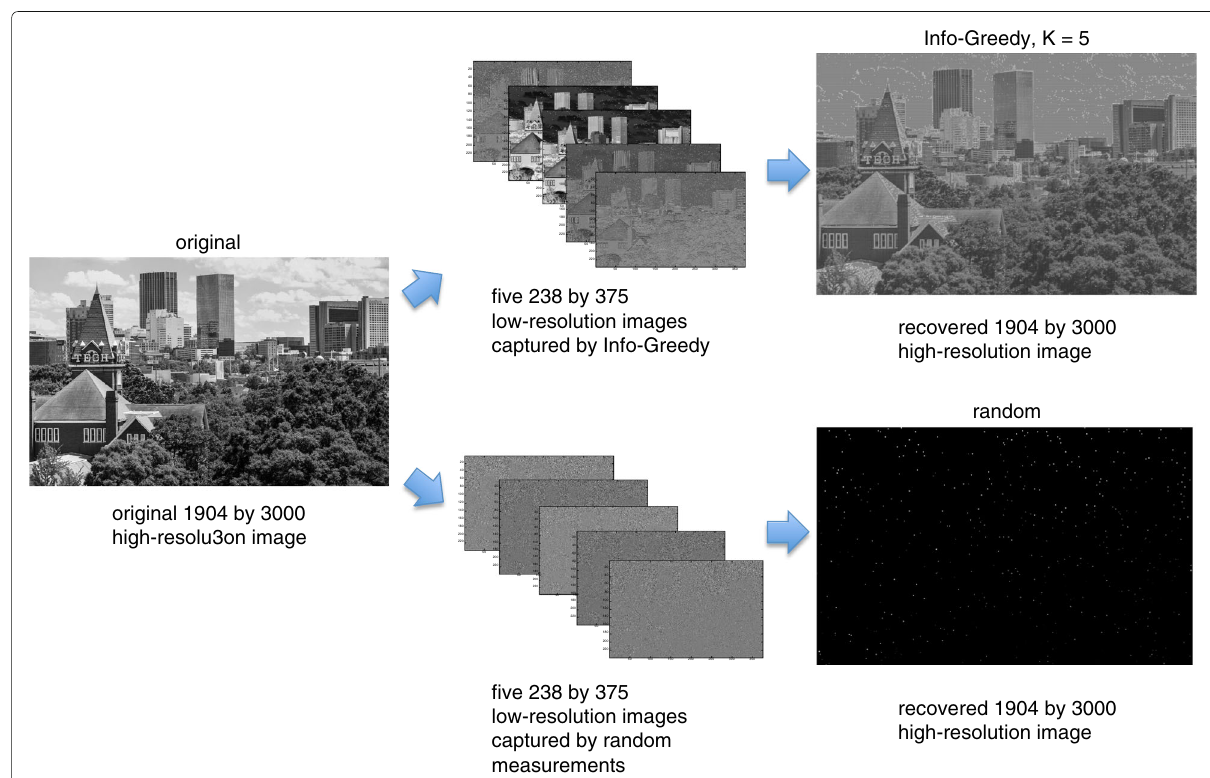
Fig. 1 Value of information in sensing a high-resolution image of size 1904 × 3000. Here, compressive linear measurements correspond to extracting the so-called features in compressive imaging [1–3]. In this example, the compressive imaging system captures five low-resolution images of size 238 × 275 using masks designed by Info-Greedy Sensing or random sensing (this corresponds to compressing the data into 8.32% of its original dimensionality). Info-Greedy Sensing performs much better than random features and preserves richer details in the recovered image. Details are explained in Section